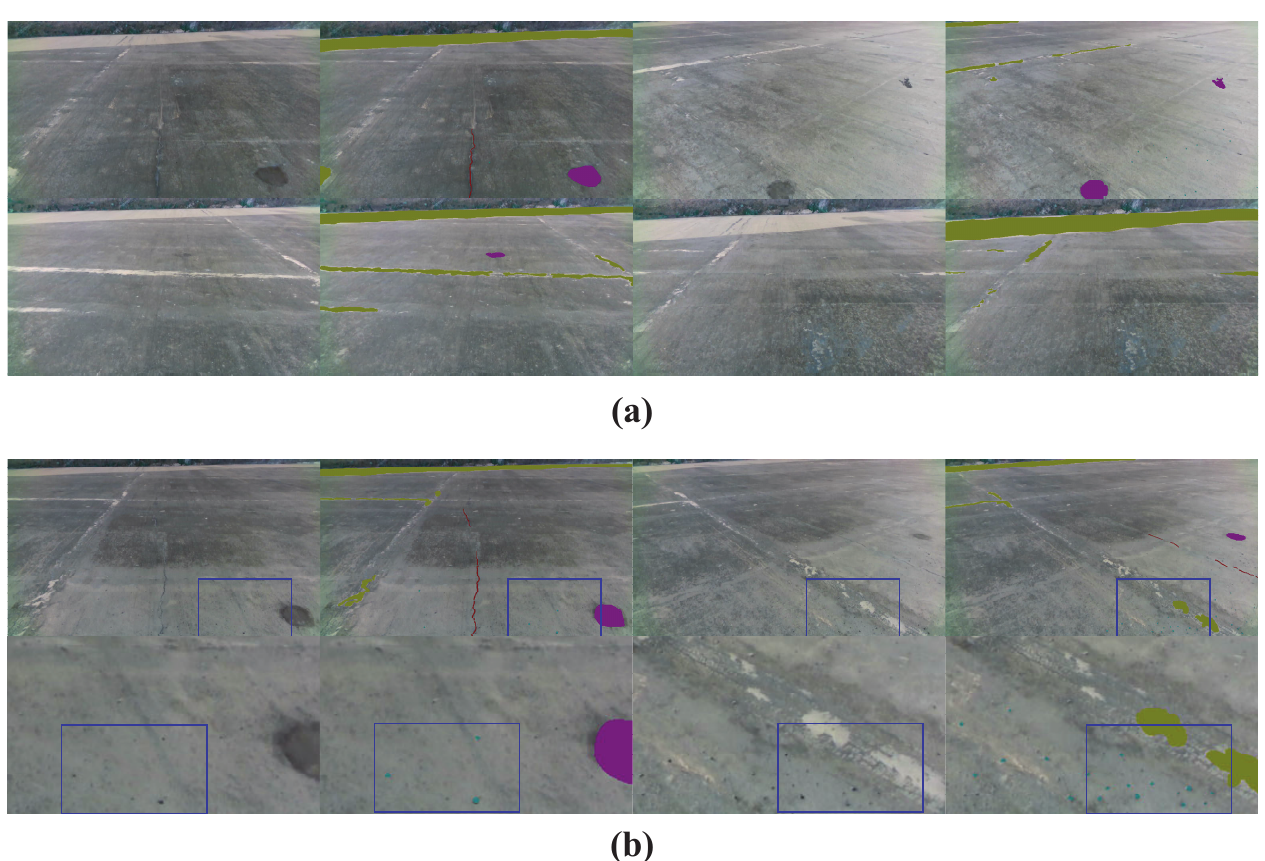
Figure 3. Image collection and labeling. The collection’s original images are shown in the first and third columns. Labeled images are shown in the second and fourth columns. ( a ) shows the original images themselves, ( b ) the second row shows zoom-in visualization of the first row in the blue box. Labeled defects include cracks in red, patched areas in ochre, erosion in purple, and spots in nattier